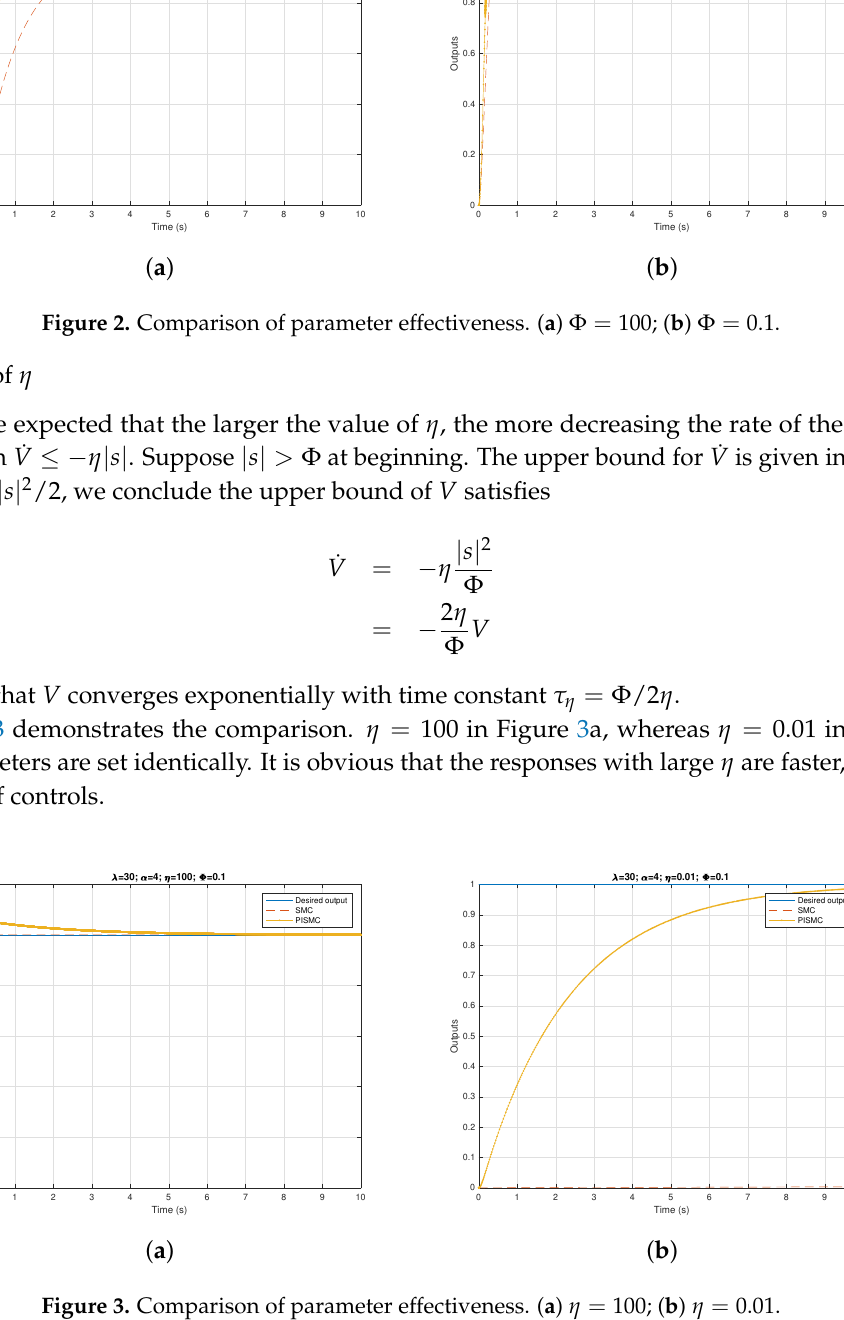
Figure 3. Comparison of parameter effectiveness. ( a ) η = 100; ( b ) η =